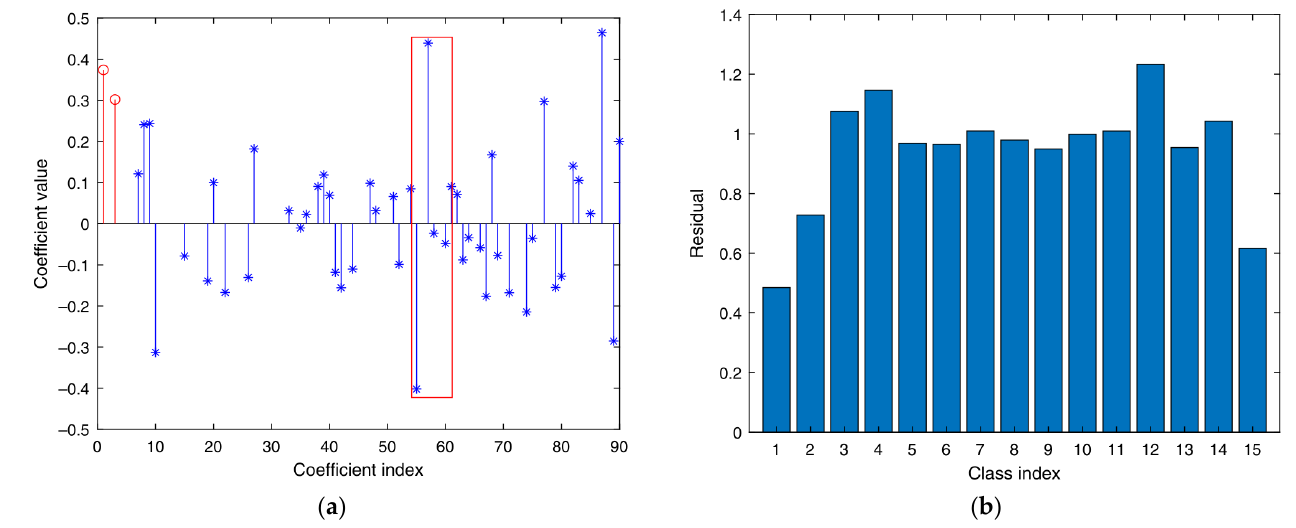
Figure 2. ( a ) Coefficients obtained by SRC method; ( b ) residuals obtained by SRC method.